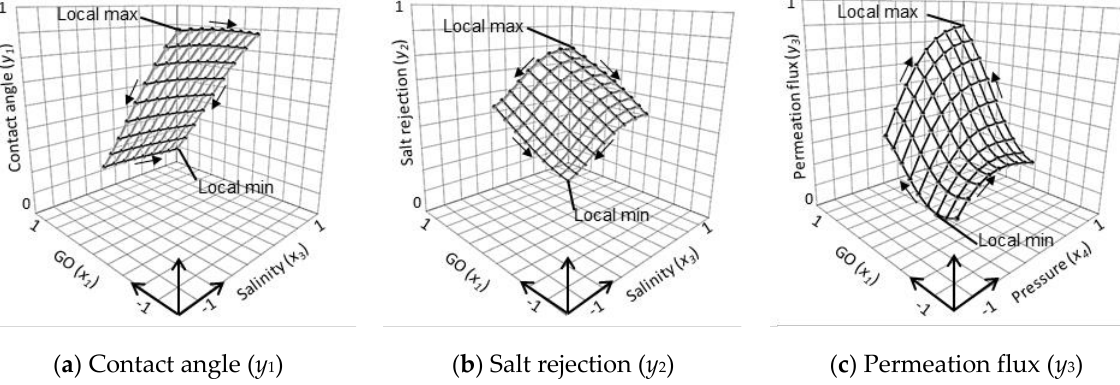
Figure 5. Single-layer response surfaces simulated by the ANN model.